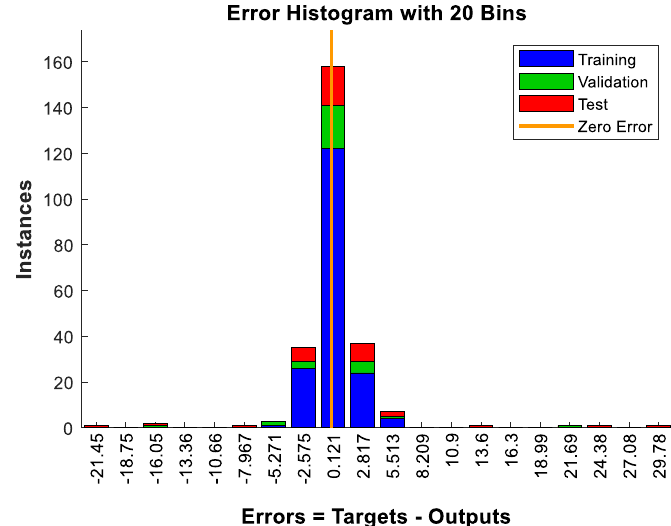
Figure 9. Training state results for performance checking.